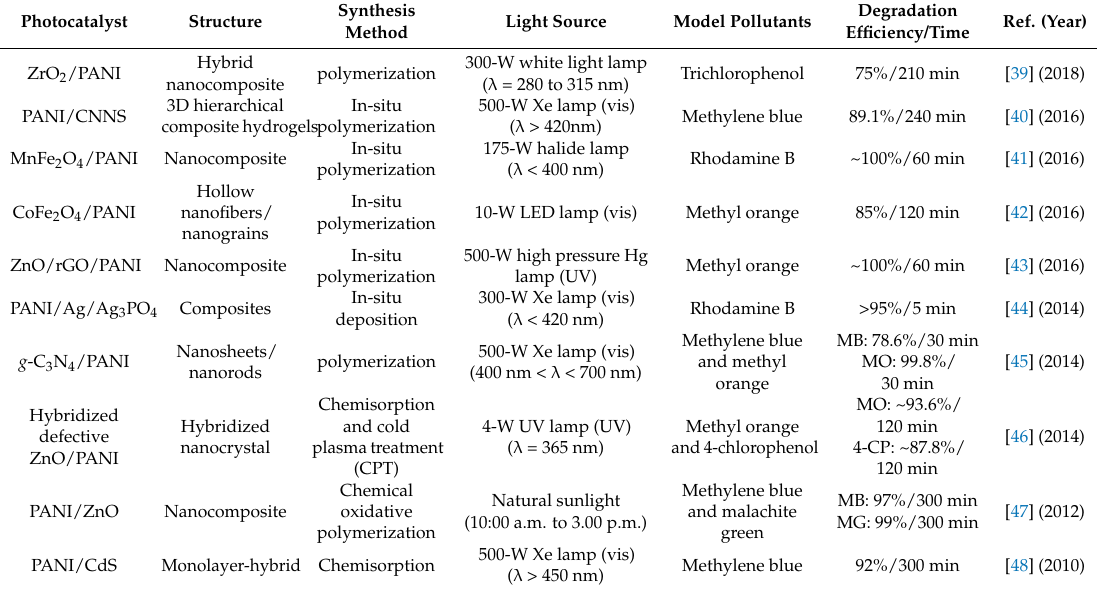
Table 3. Compositions, preparation methods, testing conditions, and photodegradation efficiency of other polyaniline based composite